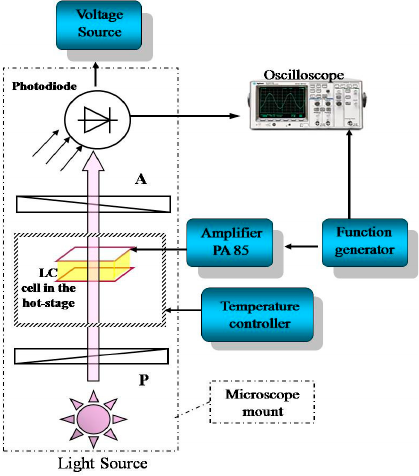
Figure 1. Schematic representation of the implemented electro-optic measurement technique.